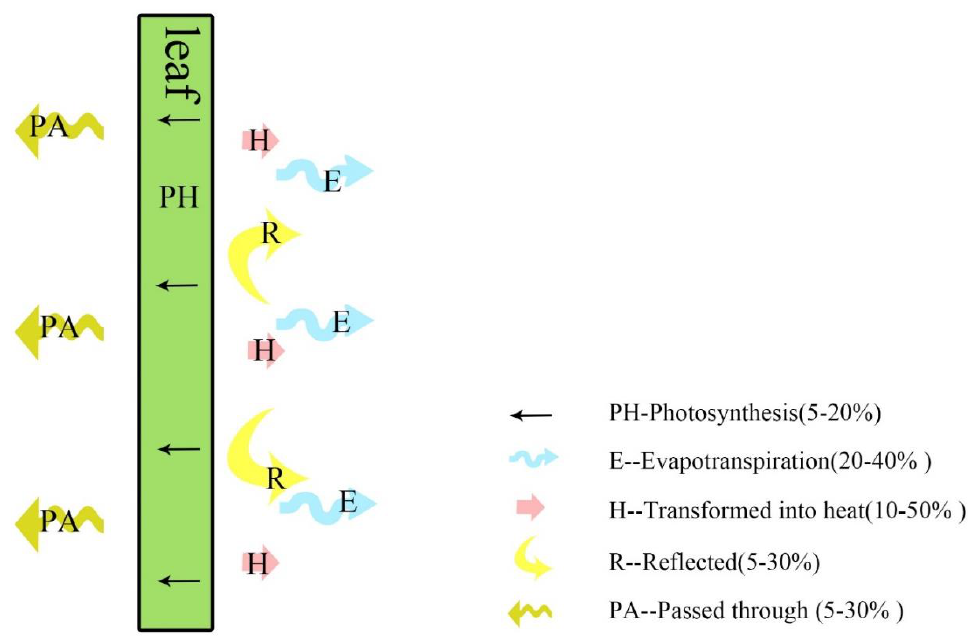
Figure 1. Plant leaf heat balance analysis.